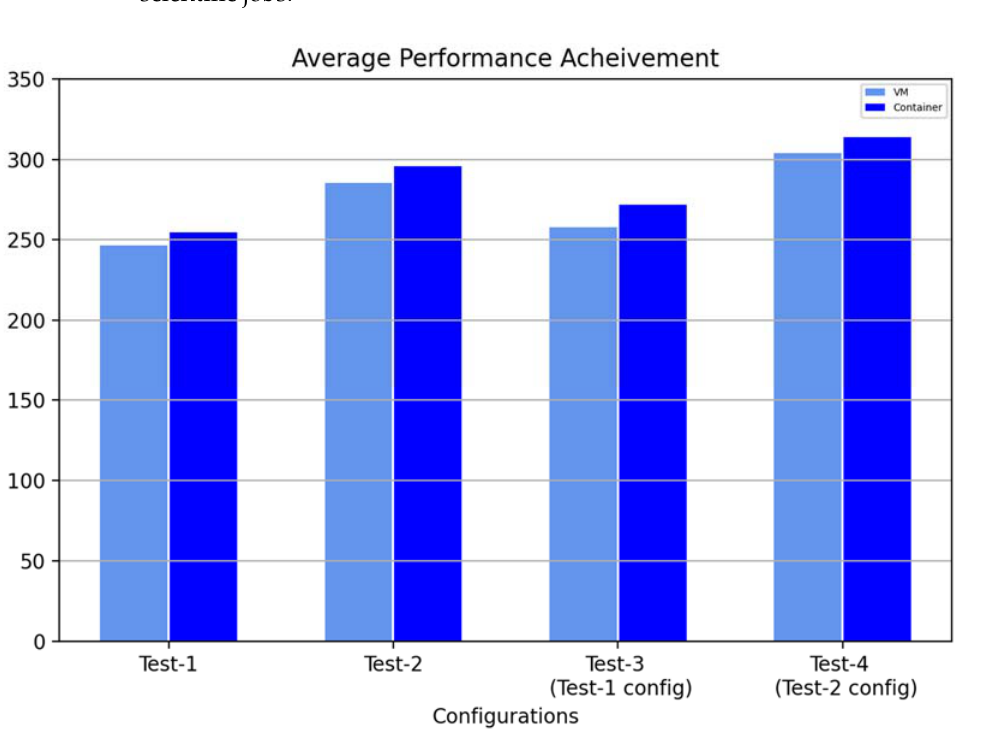
Figure 6. The average VMs performance achievement by each test case.